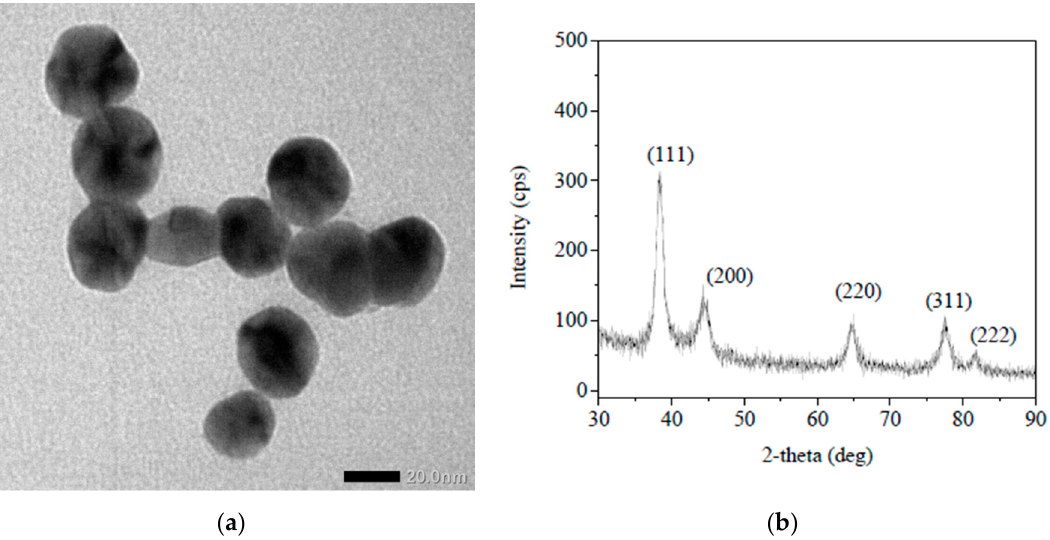
Figure 1. ( a ) TEM image of colloidal Ag nanoparticles (AgNPs) prepared in polyvinyl alcohol (PVA) solution by use of ascorbic as a reducing agent, ( b ) XRD pattern of AgNPs recorded after separation by centrifuge and drying.